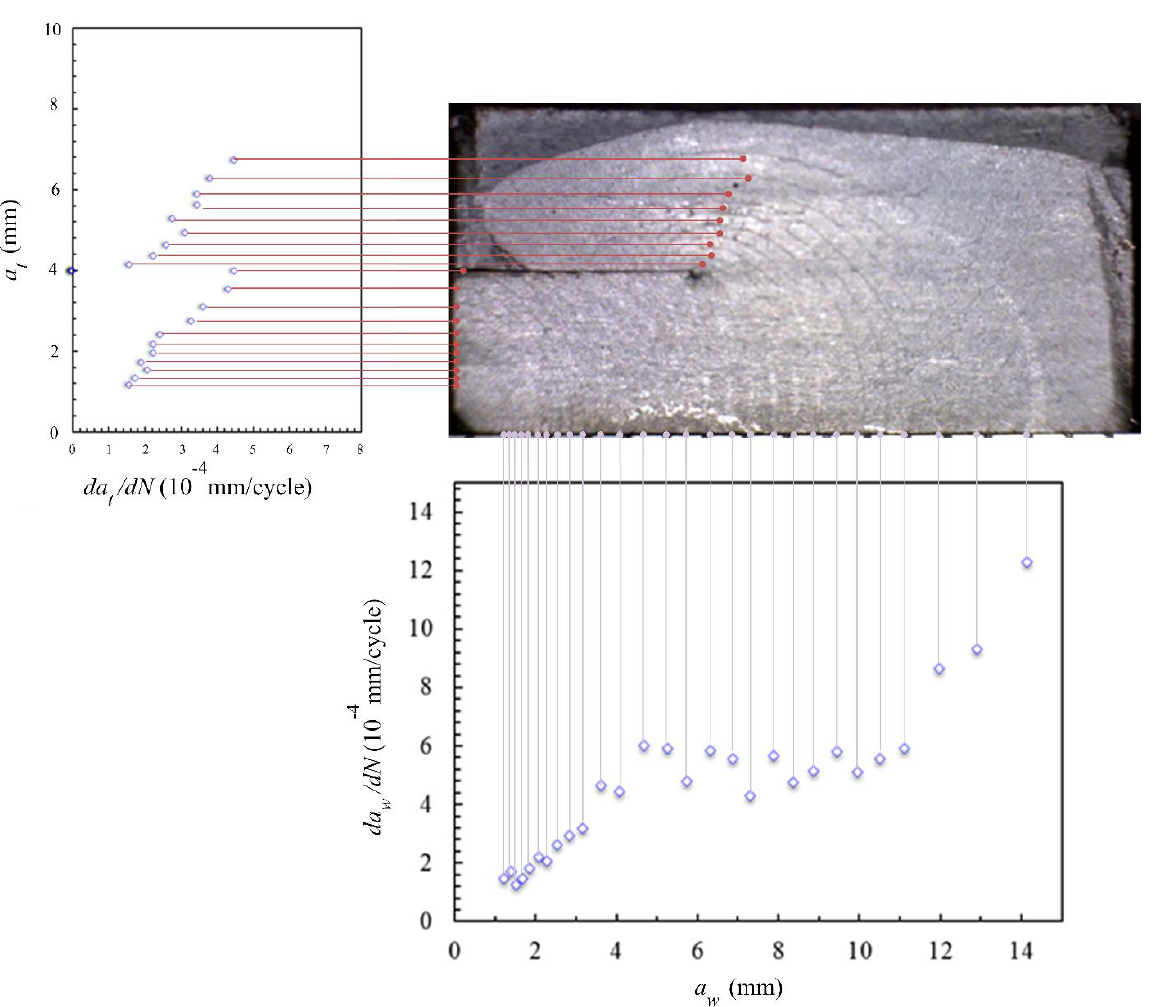
Figure 9. Variation in FCG rate with crack length a w and a t for specimen 1.